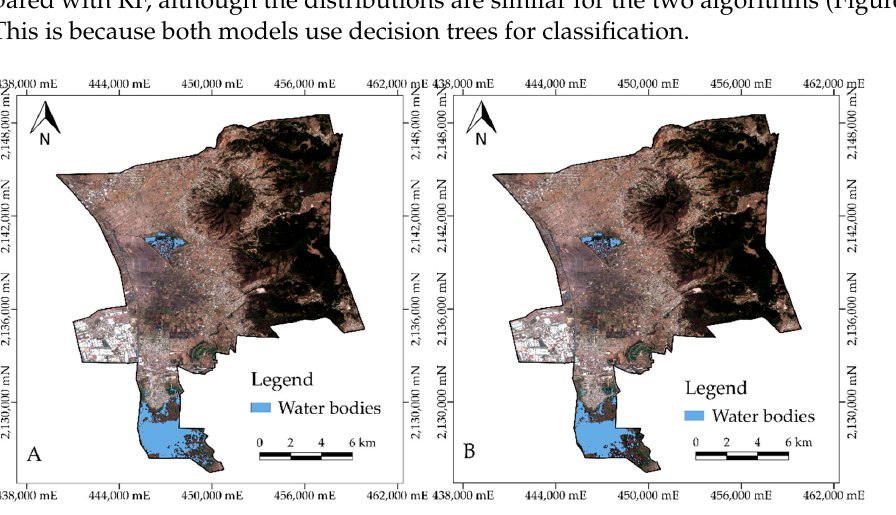
Table 9. Comparison metrics obtained from GB and RF algorithms for the best combination for the rainy season.